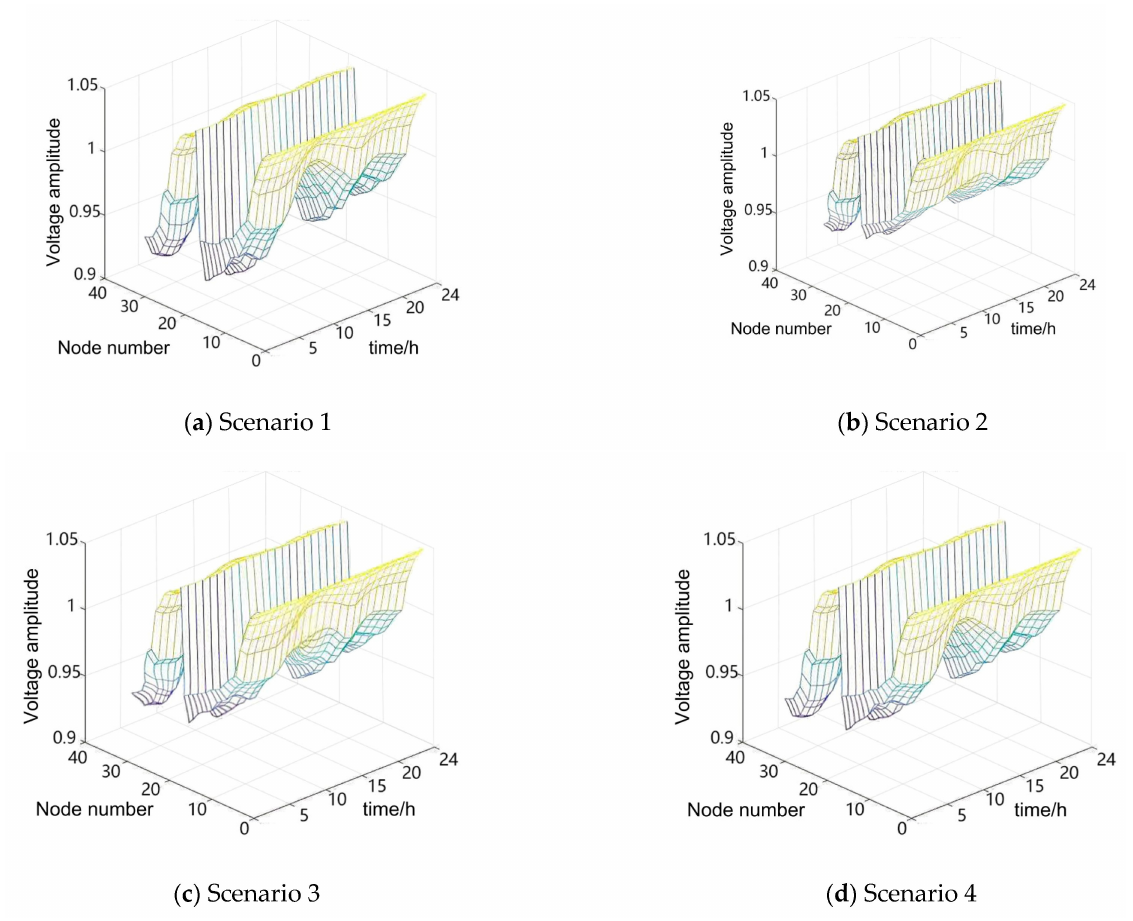
Figure 10. System node voltage curve in different scenarios. Table 5. Optimization results in different